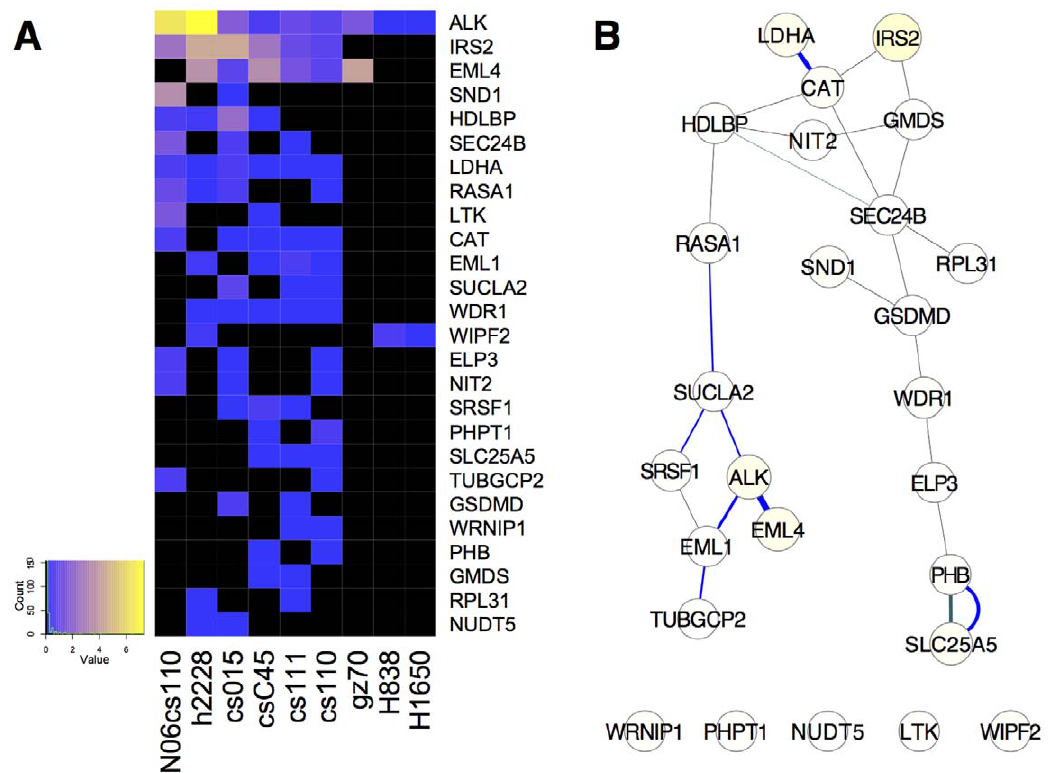
Figure 5. Filtered cluster containing ALK, graphed as a heat map ( A ) and protein-interaction network ( B ) . This cluster is derived from clusters combined from Figure S8B and C in which proteins present in a single sample, or samples containing a single gene, were filtered. This cluster had twelve-fold more edges, ten-fold greater edge weight than the average random cluster, and 7 more edges than would be expected from these nodes in the entire lung cancer network. Individual edges are shown from String (blue) and GeneMANIA (black).